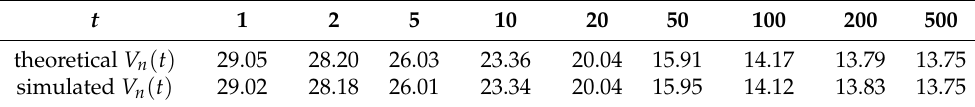
Table 2. Theoretical vs. simulated average waiting times at t .